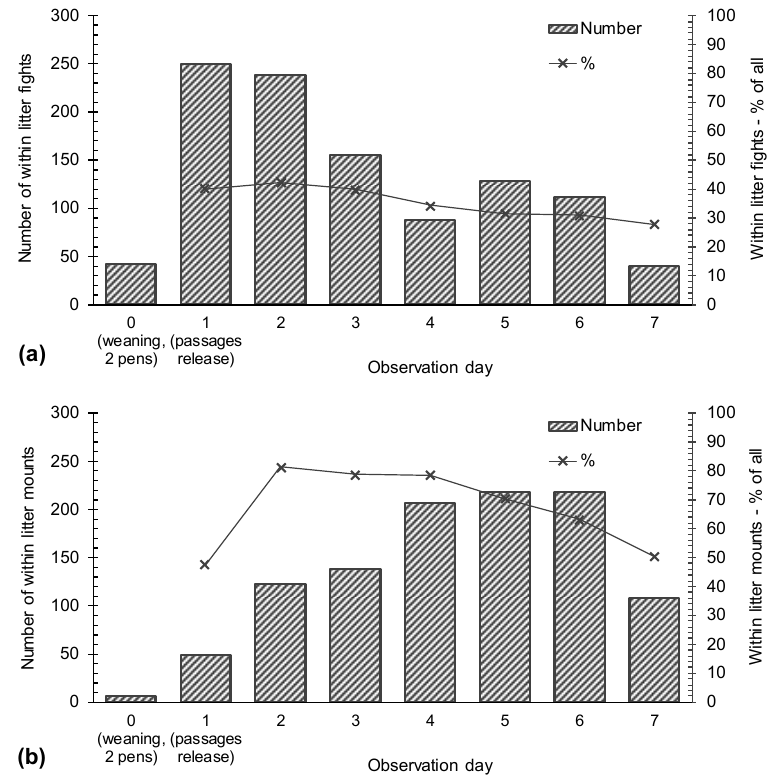
Figure 2. Temporal dynamics of within-litter interactions; ( a ) fighting, ( b ) mounting.